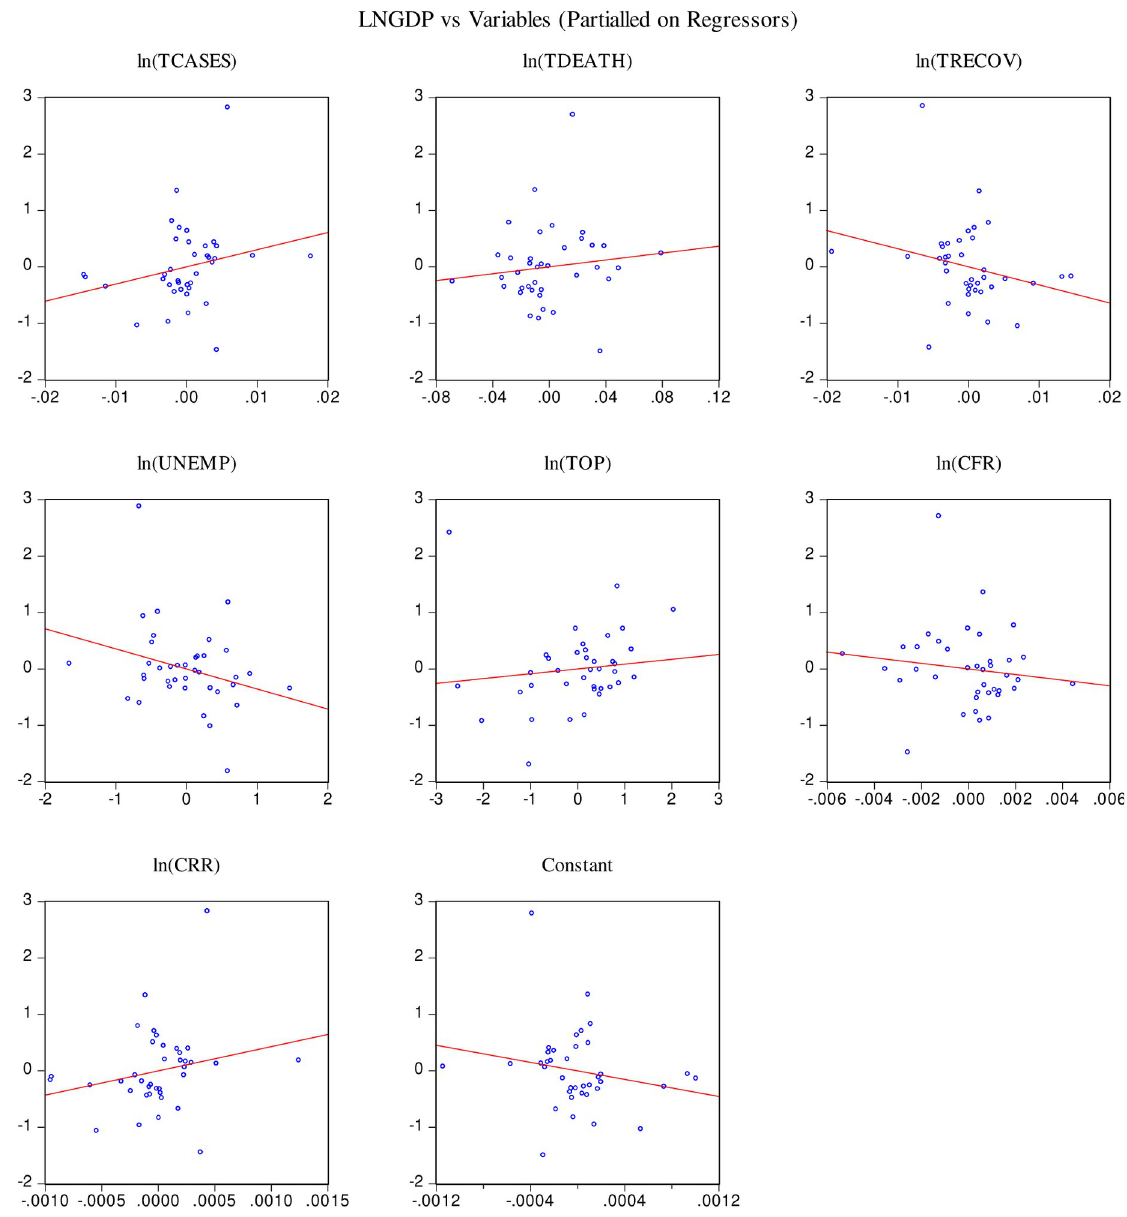
Fig 2. Leverage plots for ln(GDP). Source: Authors stimates. Note: ln(TCASES) shows natural logarithm of total cases, ln(TDEATH) shows natural logarithm of total deaths reported, ln(TRECOV) shows natural logarithm of total recovered cases, ln(GDP) shows natural logarithm of GDP, ln(SMP) shows natural logarithm of stock market performance, ln(TOP) shows natural logarithm of trade openness, ln (CFR) shows natural logarithm of case fatality ratio, ln(CRR) shows natural logarithm of case recovered ratio, and ln(UNEMP) shows natural logarithm of